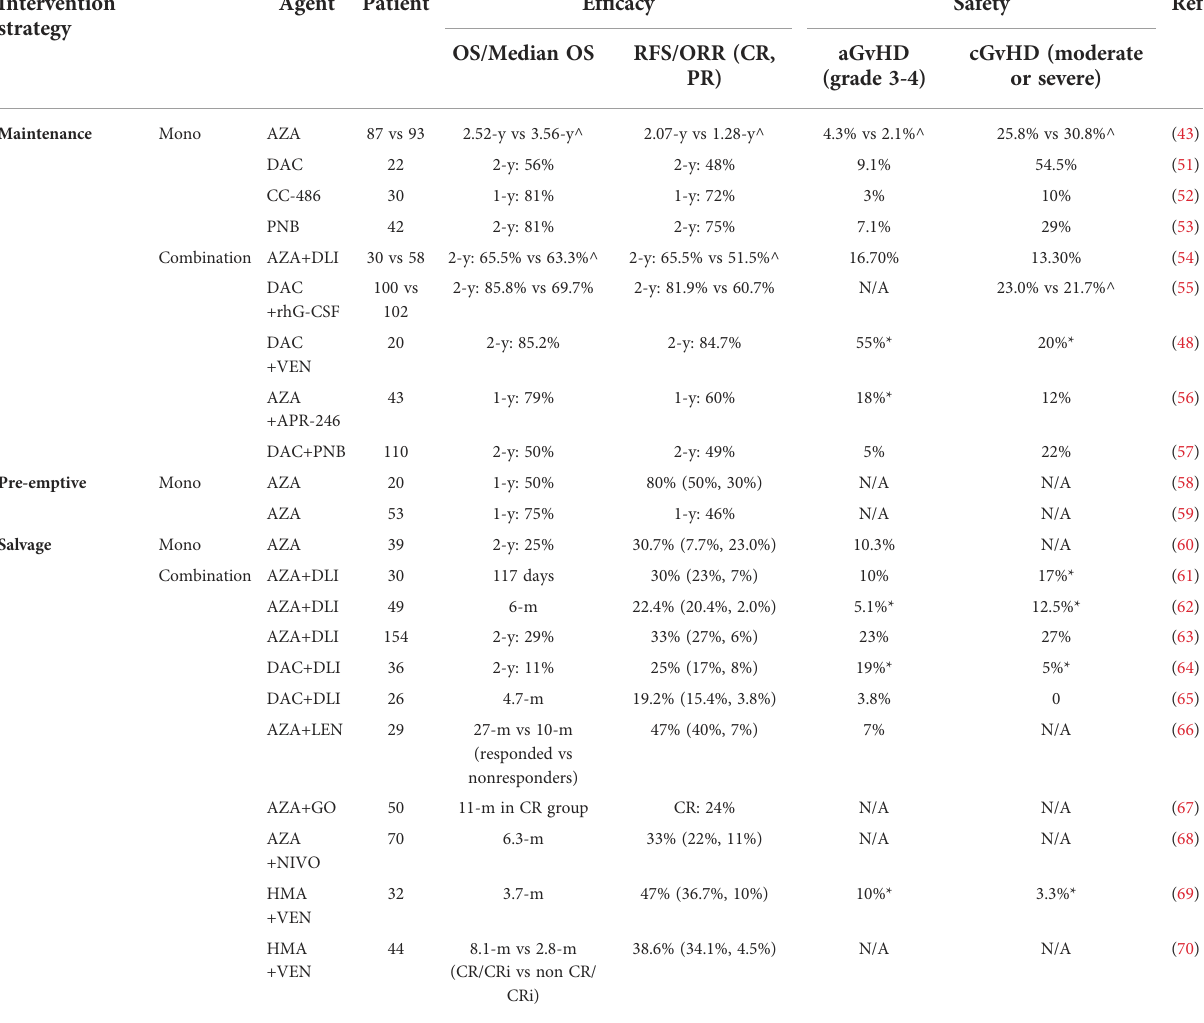
TABLE 3 The use of hypomethylating agents after hematopoietic stem cell transplantation in MDS or AML. Intervention